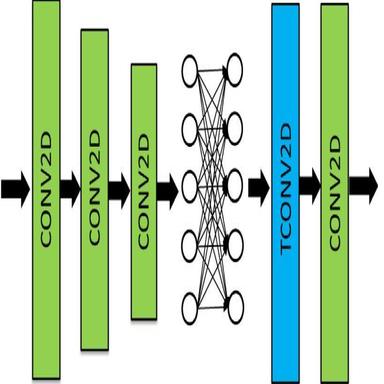
The RVE-FCNN layer of the RVE-net for material properties calibration.